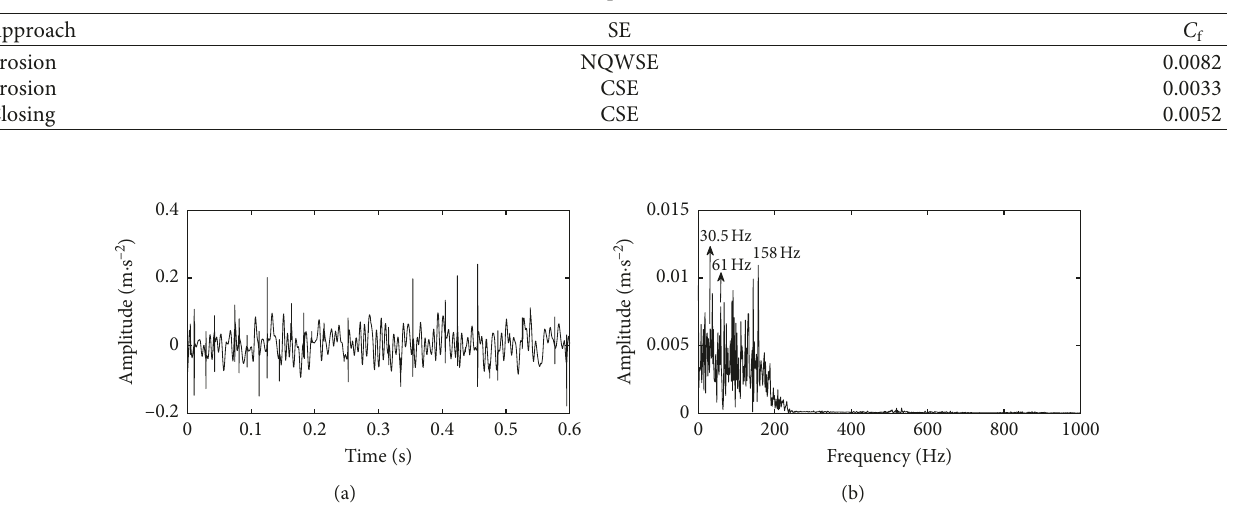
Figure 7: Closing results of CSE. (a) Waveform in the time domain. (b) Frequency spectrum. Table 1: Comparison of C f .